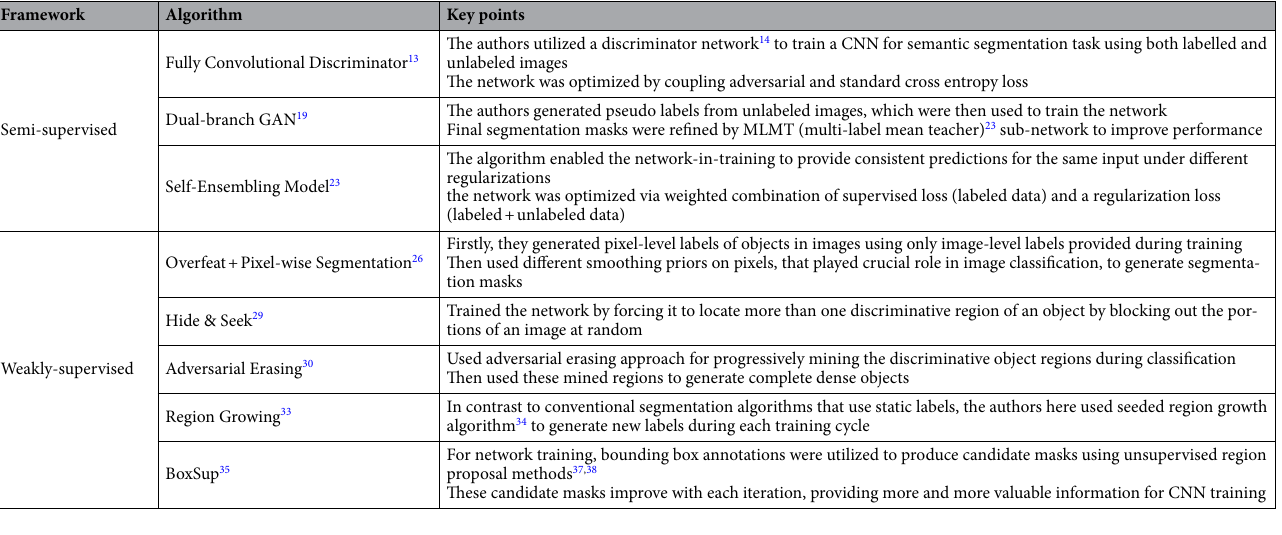
Table 1. Summary of state-of-the-art algorithms in domain of weakly and semi superivsed framworks for image